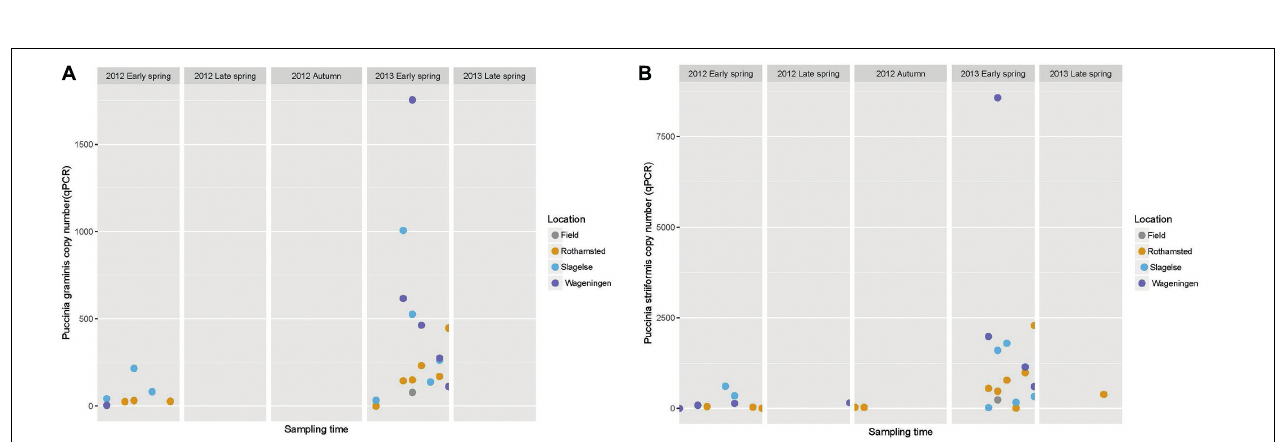
FIGURE 5 | The most abundant genera with mainly plant pathogenic during five periods in spring 2012 and 2013 and autumn 2012. Note that the graph does not represent a continuous sampling but five temporally separated periods. (A) Blumeria ; (B) Mycosphaerellaceae; (C) Monographella ( Microdochium ); (D) Sclerotiniaceae.